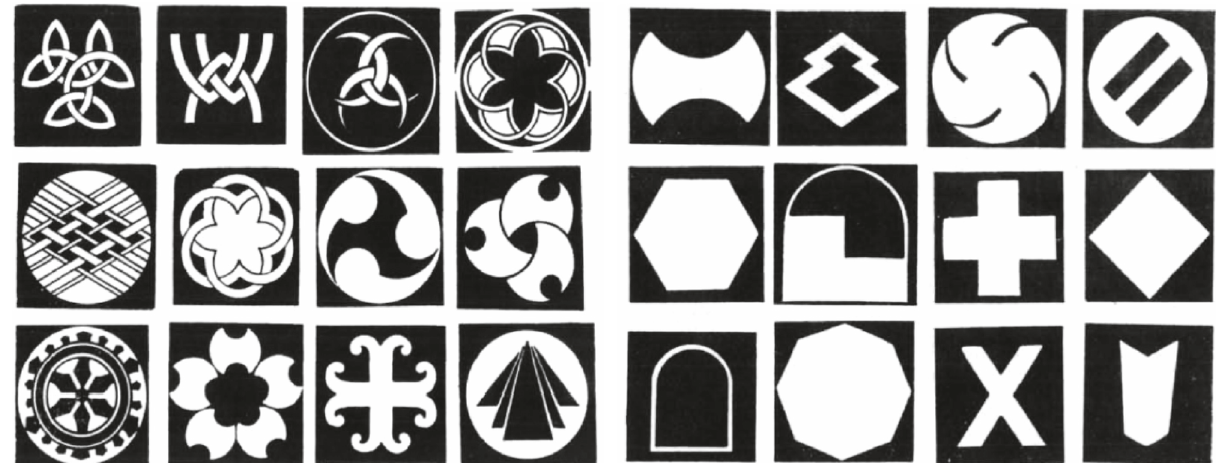
Figure 1: The twelve most-liked (left) and least-liked (right) of Eysenck’s [33]